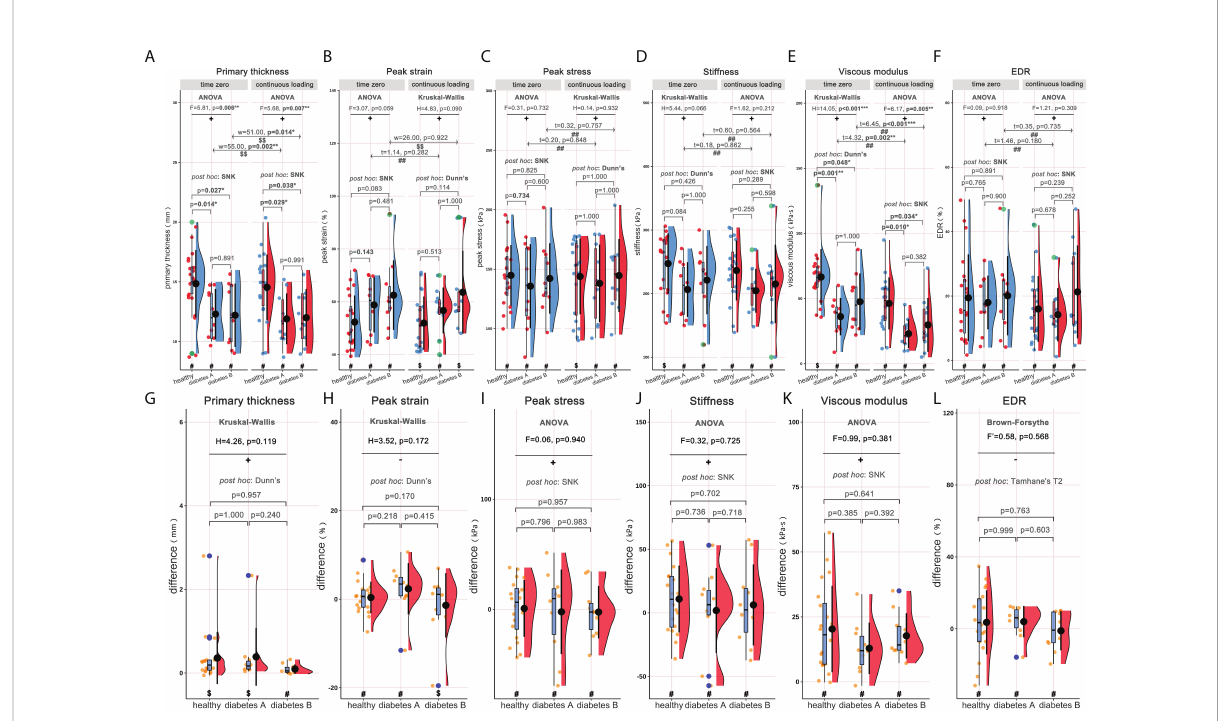
FIGURE 3 Rain-cloud plot for subgroup analysis based on length of diabetes course (diabetes A: <10years; diabetes B: ≥ 10years), depicting the material properties of heel pad, including primary thickness, peak strain, peak stress, stiffness, viscous modulus and EDR. (A – F) the material properties of heel pad in three subgroups (healthy, diabetes A and diabetes B) at time zero and following continuous loading. (G – L) the differences of material properties of heel pad between two loading statuses in three subgroups. # , data follow the normality distribution; $ , data didn ’ t follow the normality distribution; ## , the difference between two loading statuses follow the normal distribution; $$ , the difference between two loading statuses didn ’ t follow the normal distribution; +, meet the homoscedasticity assumption; -, didn ’ t meet the homoscedasticity assumption. “ F ” , “ F ’” , “ H ” , “ t ” and “ w ” represent the statistical effect sizes for ANOVA, Brown-Forsythe test, Kruskal-Wallis test, T test, and Wilcoxon test, respectively. Error bar represents the mean value and standard deviation; box plot represent the median value and quartiles. ANOVA= analysis of variance; EDR= energy dissipation rate. *, p<0.050; **p<0.010;